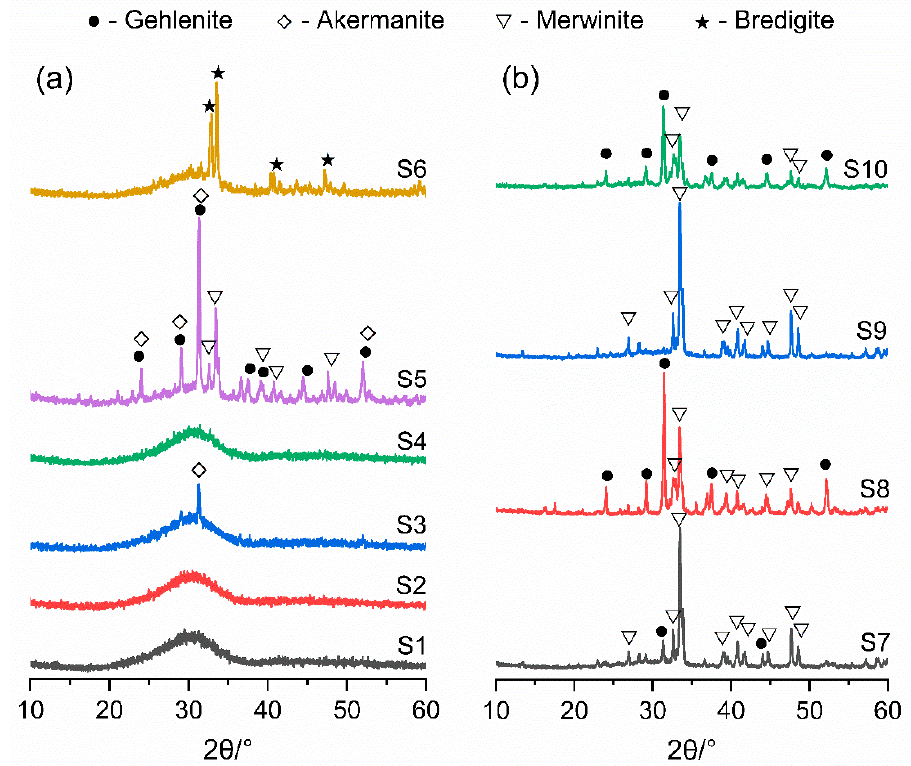
Figure 5. X-ray diffraction (XRD) patterns of anhydrous slags ( a ) CM/SA ≤ 1.05 ( b ) CM/SA > 1.05. Table 6. Phase contents of air quenched slags determined by XRD-Rietveld analysis (wt.%).